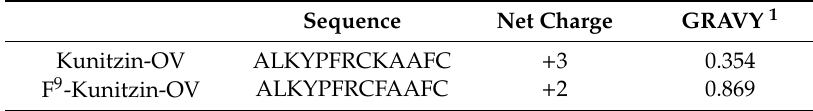
Table 1. Sequences and physicochemical properties of Kunitzin-OV and its Phe-substituted variant. Sequence